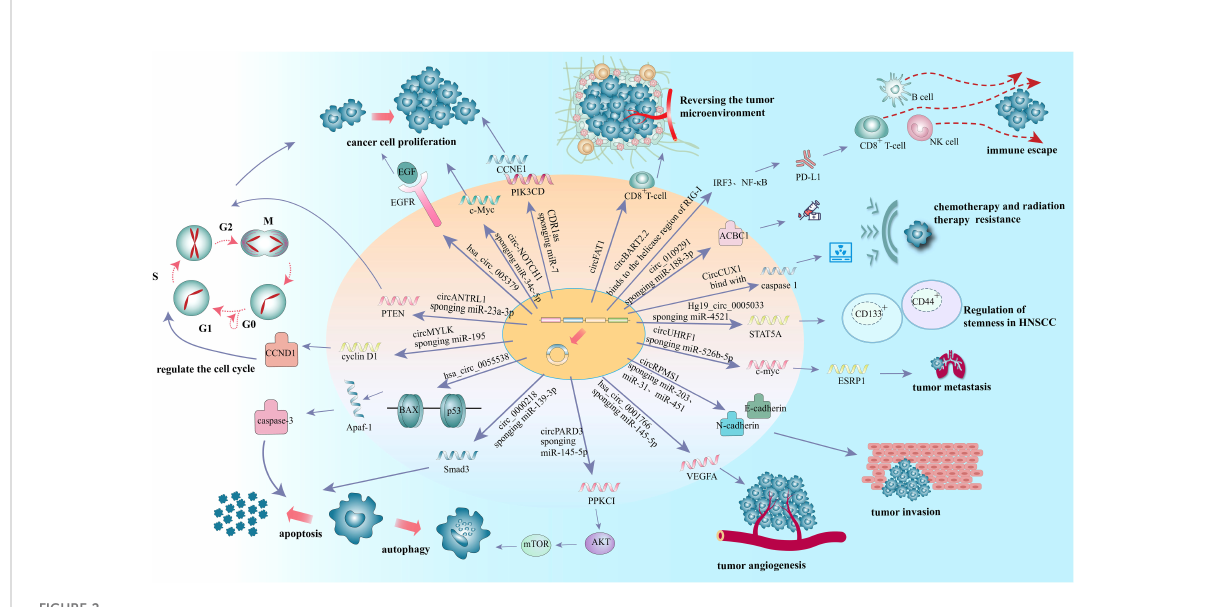
FIGURE 2 The regulatory roles of circRNAs in the occurrence and development of